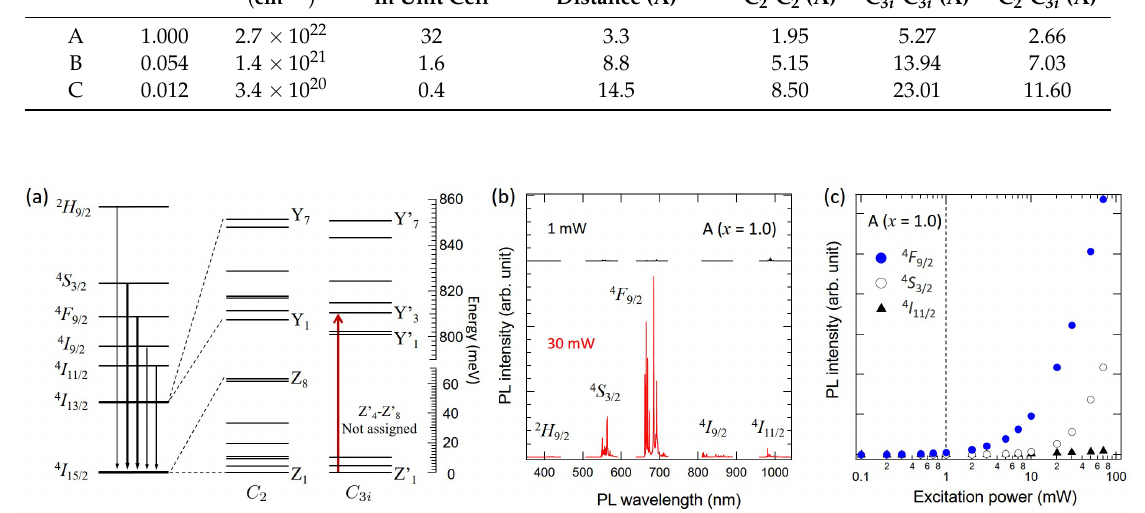
Figure 3. ( a ) Schematic of the energy levels of Er 3 + and the closeup views of 4 I 13/2 and 4 I 15/2 manifolds (after reference [21]). ( b ) The upconversion photoluminescences (UC-PLs) from various manifolds in Sample A with P exc = 30 mW (lower panel, red) and P exc = 1 mW (upper panel, black) under Y (cid:48) resonant excitation ( λ exc = 1530.5 nm) at 4 K. The PL intensities are scaled relatively between both P exc . ( c ) Excitation power dependences of the UC-PL intensities corresponding to the three manifolds, 4 F 9/2 (solid circles), 4 S 3/2 (open circles), and 4 I 11/2 (triangles) in Sample